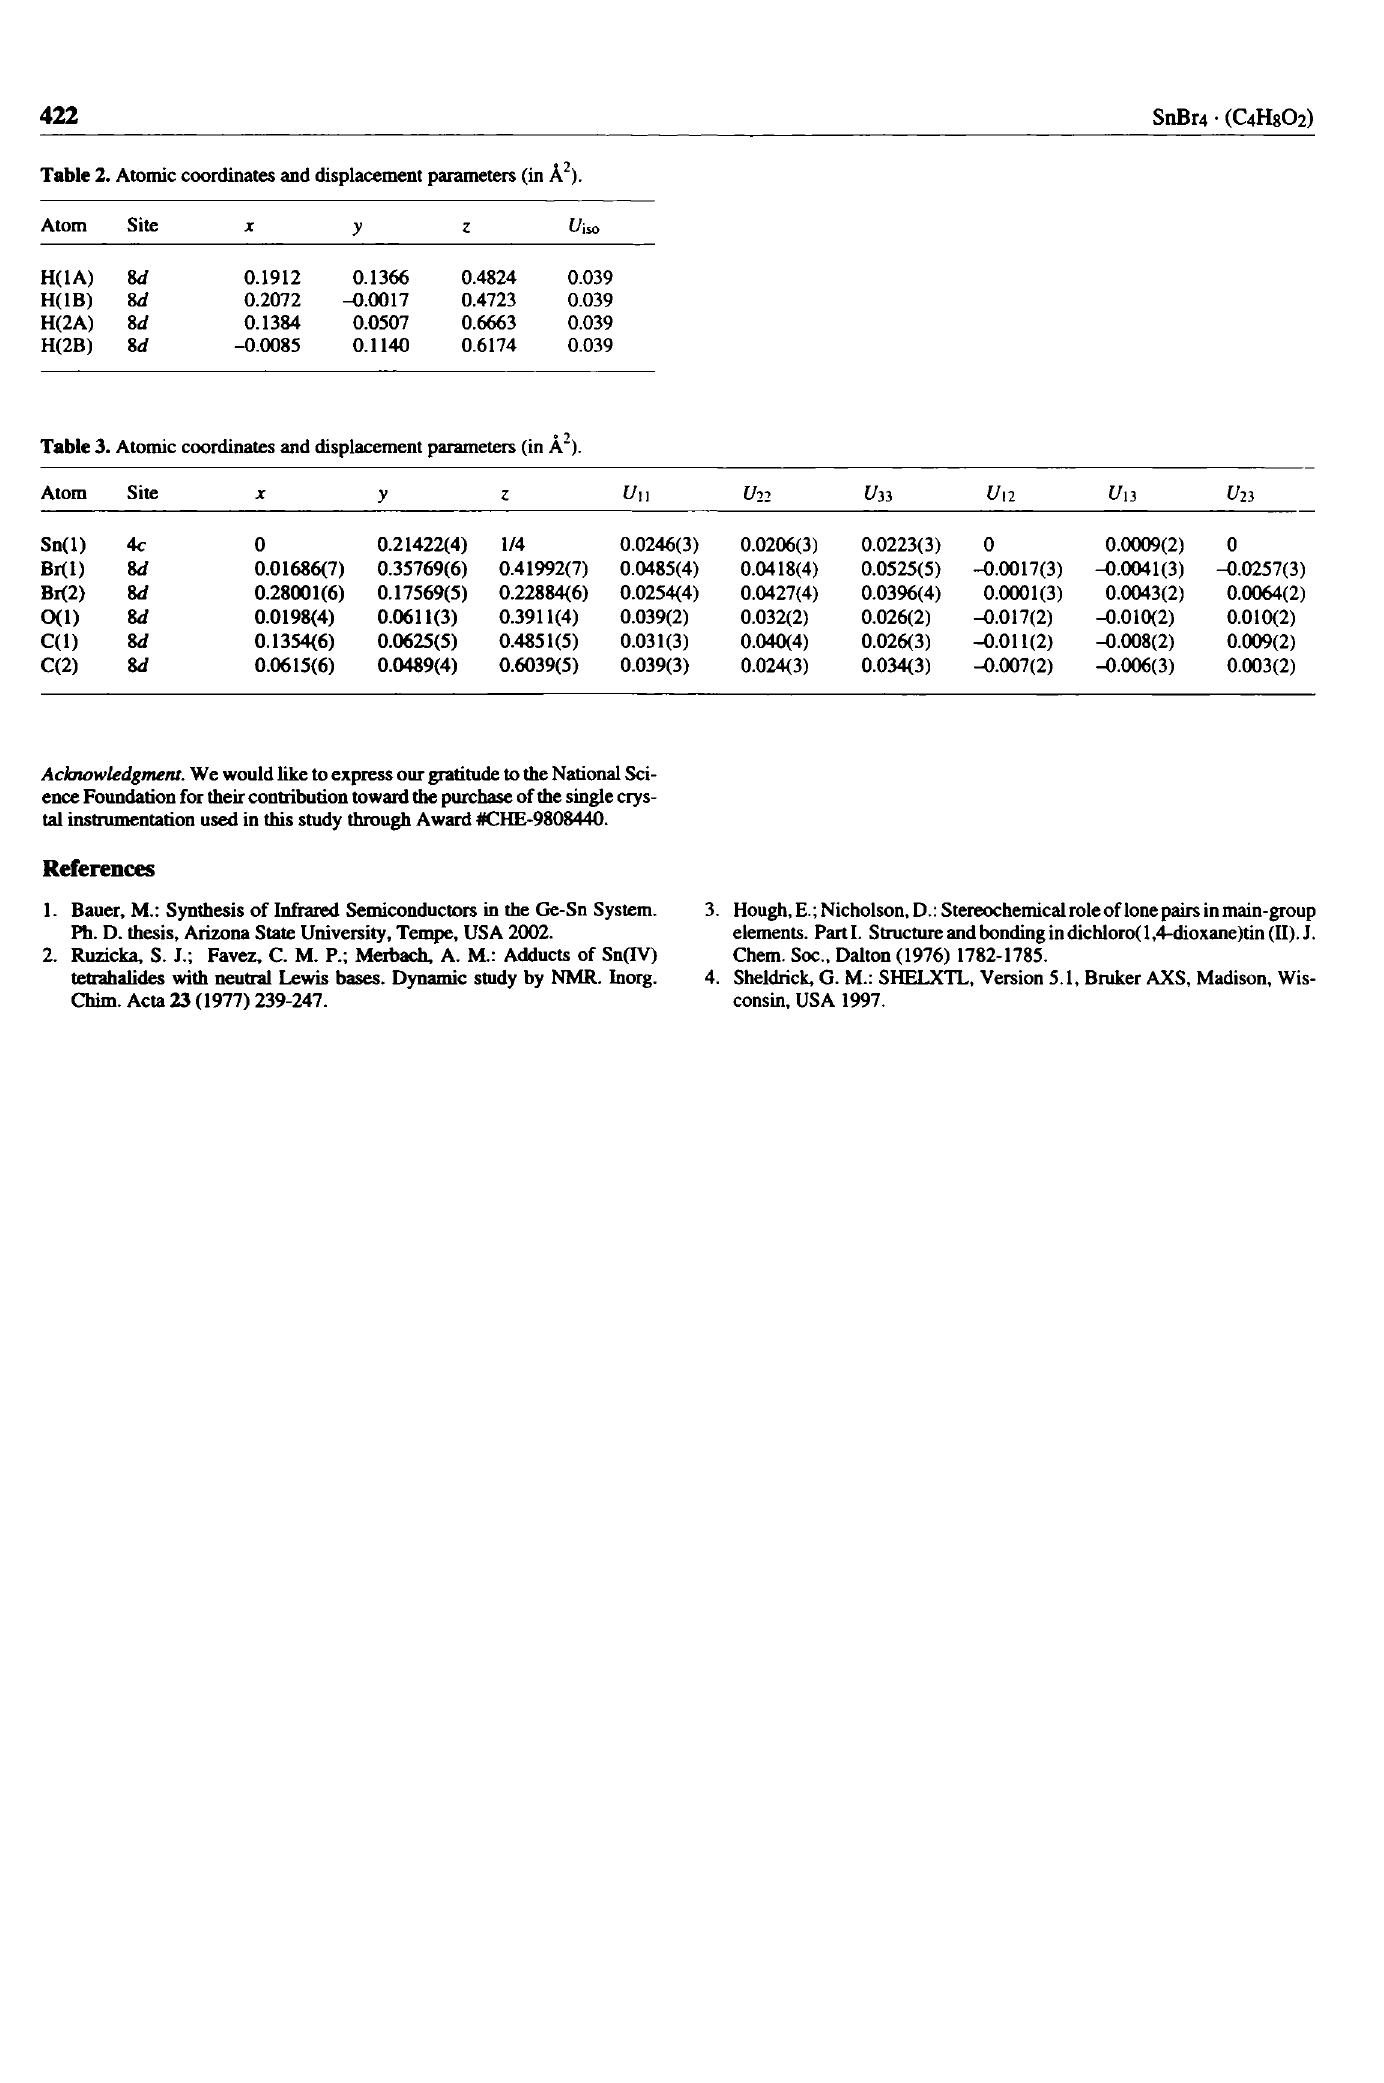
Table 3. Atomic coordinates and displacement parameters (in A 2